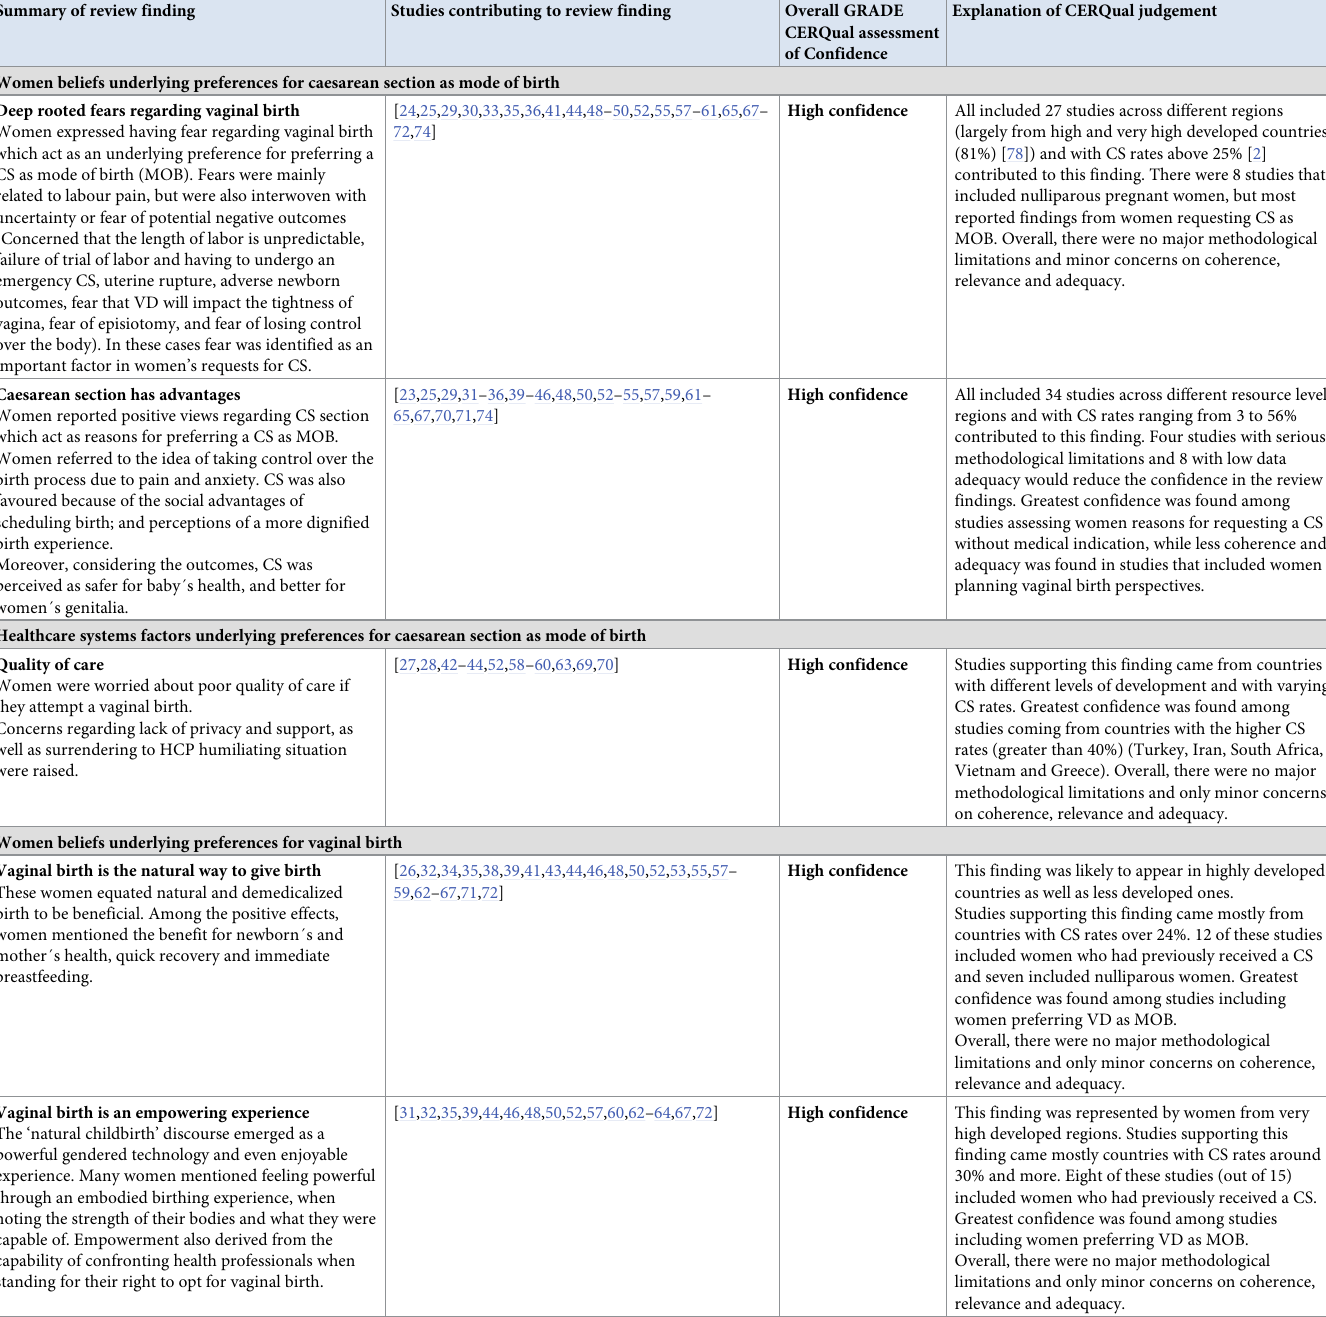
Table 3. Summary of qualitative